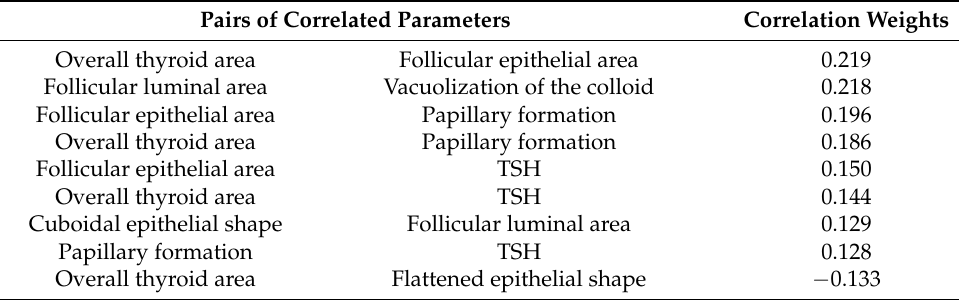
Table 4. Correlation weights for the pairs of parameters based on t he PLS model.